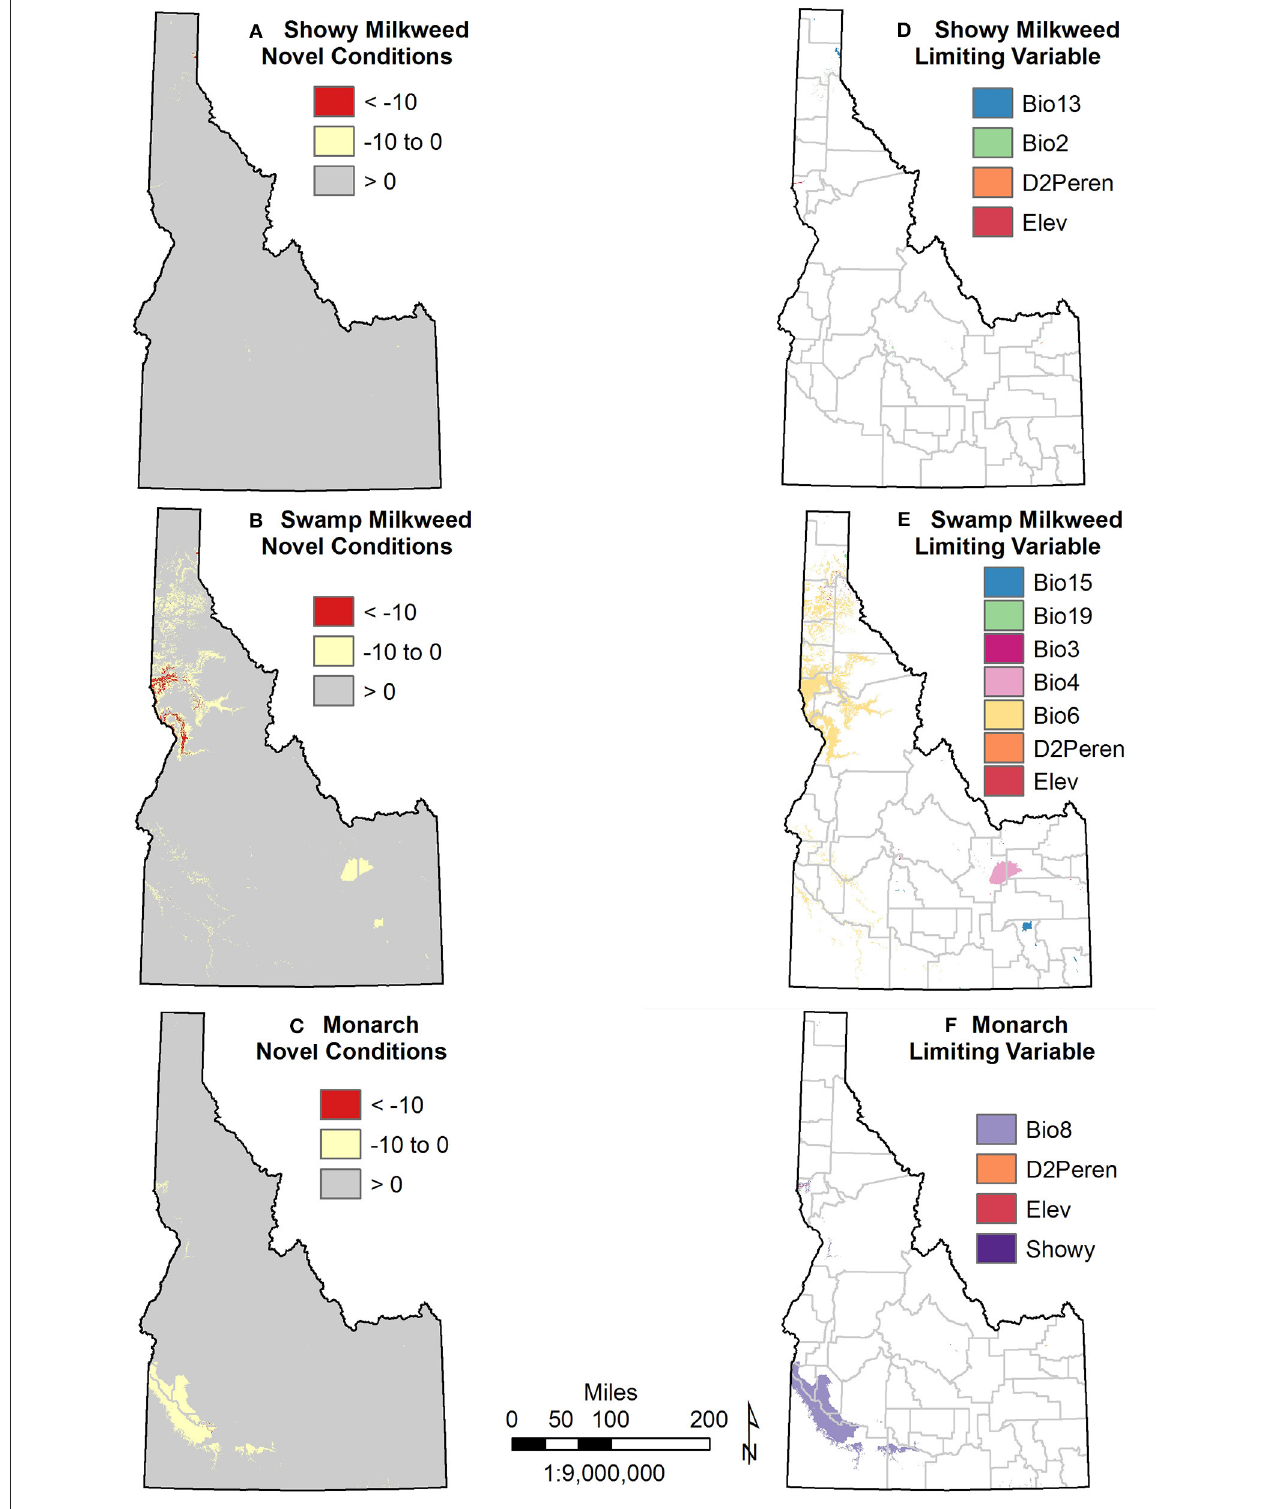
FIGURE 7 | Model uncertainty as indicated by novel conditions and limiting variables for showy milkweed (A,D) , swamp milkweed (B,E) , and monarch (C,F) . Only projections for the severe climate change scenario (RCP 8.5) are shown. Refer to Table 1 for variable abbreviations.